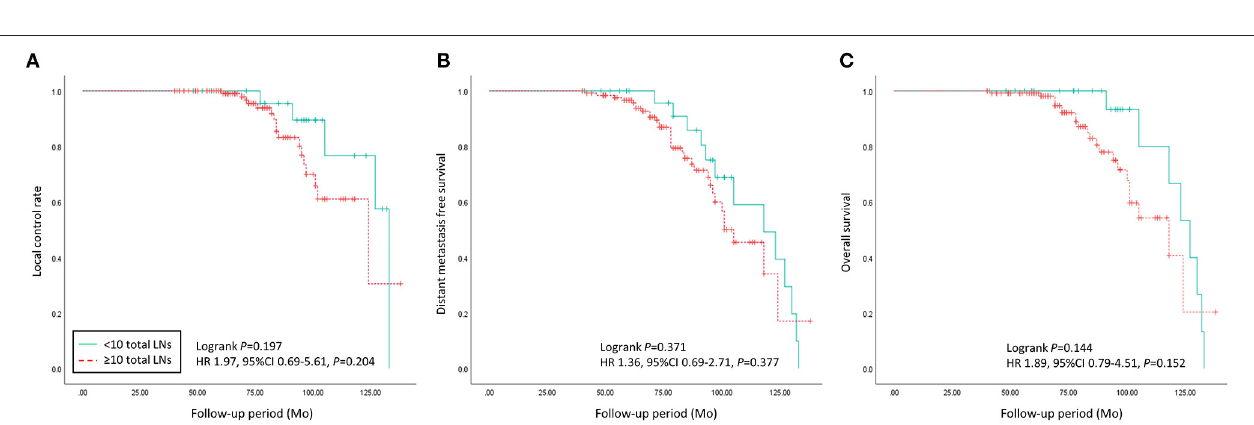
FIGURE 3 | Oncologic outcomes of patients with advanced breast cancer who underwent axillary lymph nodes dissection following neoadjuvant chemotherapy were compared between < 10 and ≥ 10 of the total axillary lymph nodes count group. (A) Local control rate, (B) distant metastasis, and (C) overall survival did not show significant differences between the two groups ( p = 0.197, 0.371, and 0.144).